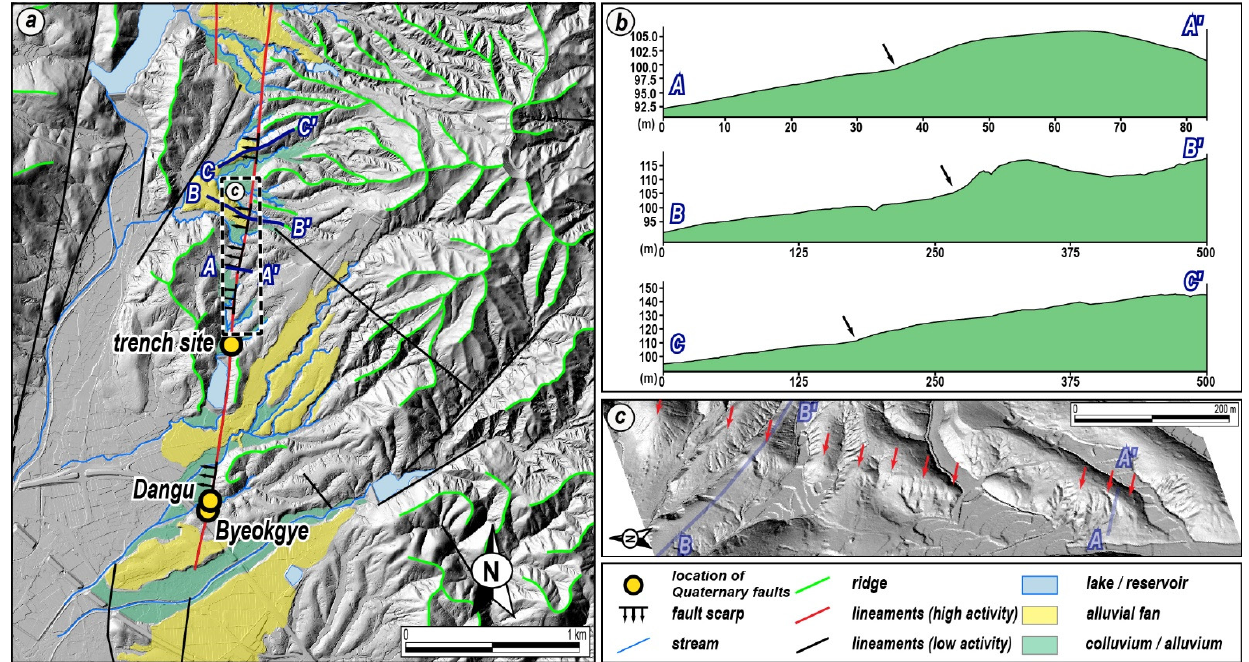
Figure 6. ( a ) Detailed topographic map of the southern area. ( b ) Topographic profiles of the fault line (blue line in ( a )) across the fault scarps. Black arrows point to knickpoints identified as fault scarps. ( c ) Hillshade image 3D view. The red arrows indicate the fault scarp, which is clearly visible to the naked eye.